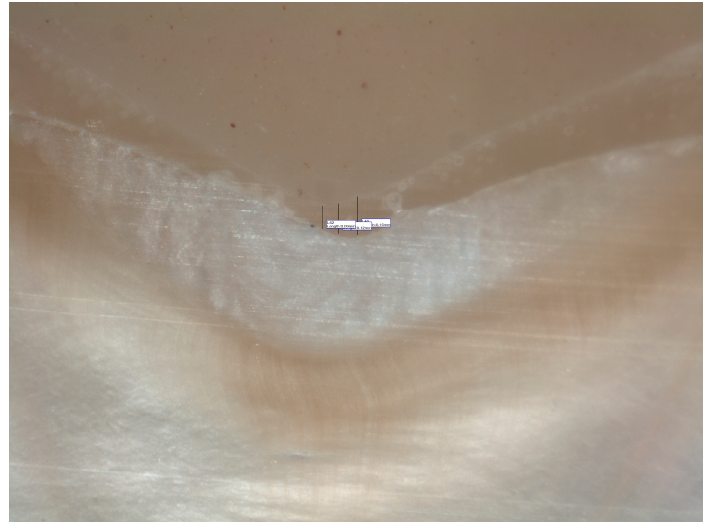
Figure 6. Stereomicroscopic view (45X) represents marginal and internal fit of a sectioned specimen